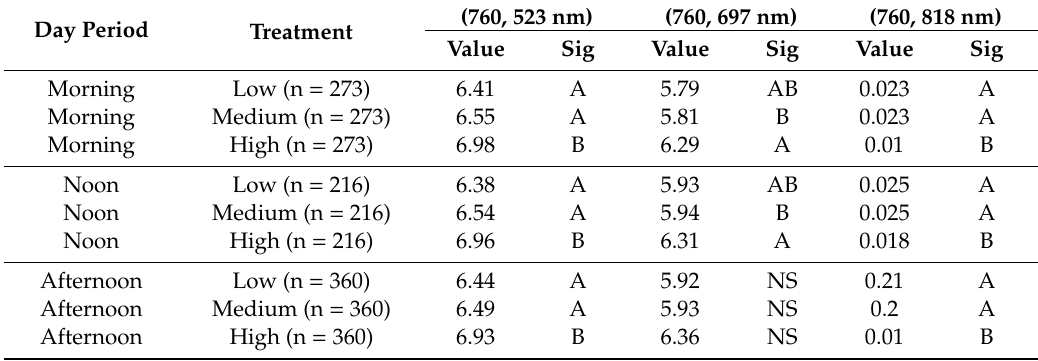
Figure 8. Mean reflectance values of the three treatment groups: potassium deficit (low, dashed line), medium (solid line), and surplus (high, dotted line) during the three day period (morning–red, noon–green and afternoon–blue). ( A1 ) entire reflectance region, ( A2 ) VIS region reflectnace, ( A3 ) NIR region reflectance, ( B1 ) entire standard normal variable (SNV) refrlectnce region ( B2 ) VIS region SNV, ( B3 ) NIR region SNV. Table 3. Normalized di ff erence indices results for the di ff erent day periods and treatment